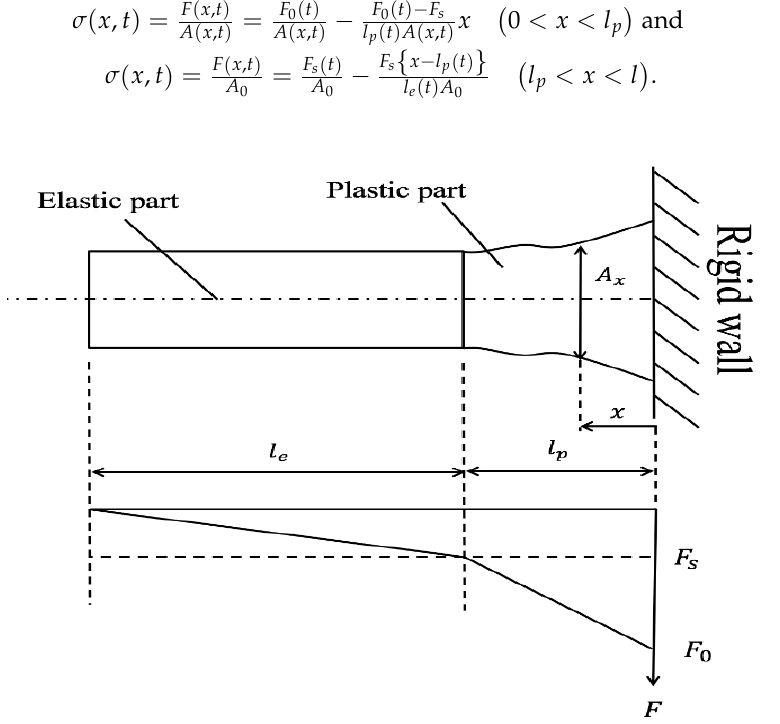
Figure 2. A schematic drawing of deformed specimen and axial distribution of internal force.